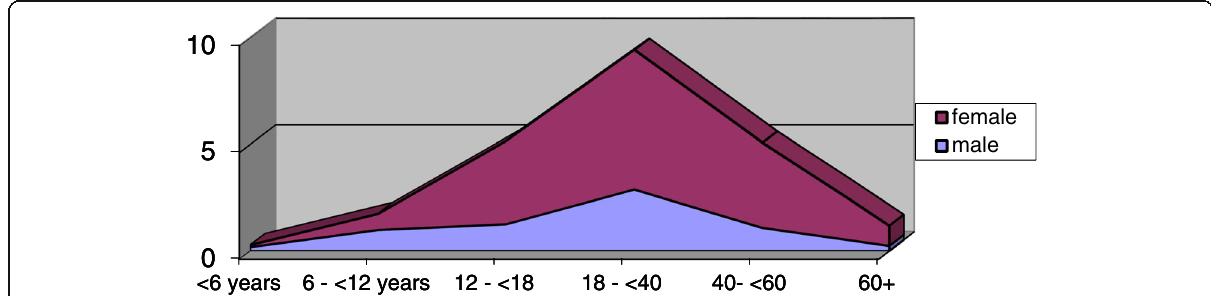
Fig. 1 Linear trend of age- and gender-specific prevalence of migraine among studied